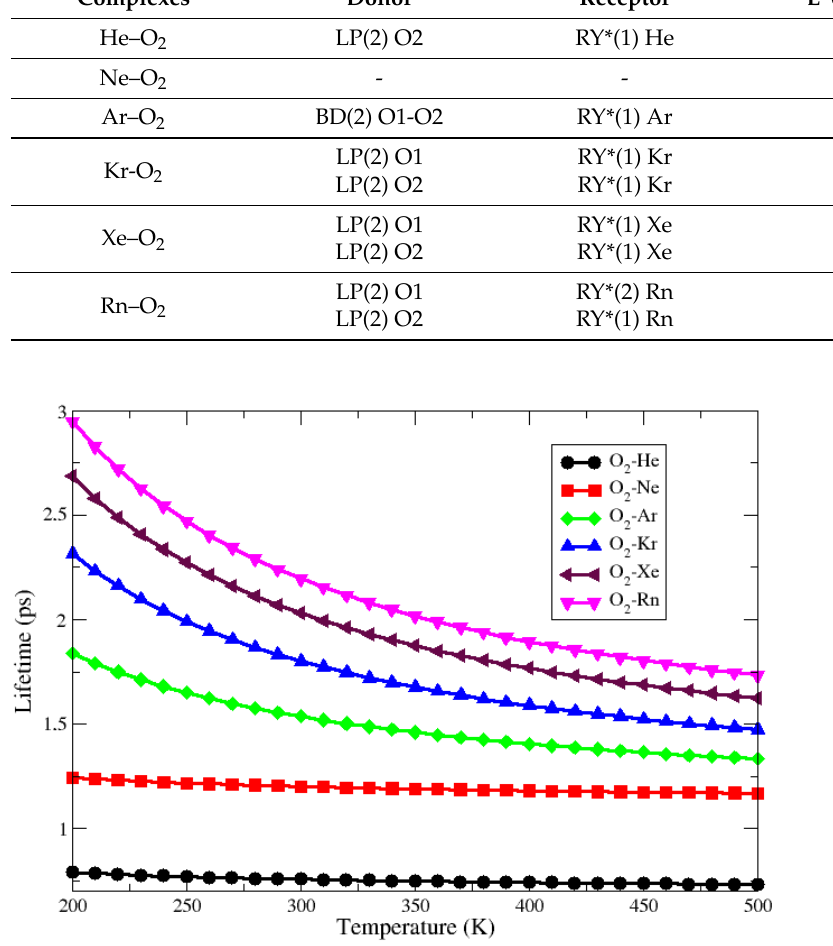
Figure 5. Lifetime behavior as a function of temperature for a Ng–O 2 compounds obtained at CCSD(t)/aug-cc-pVTZ